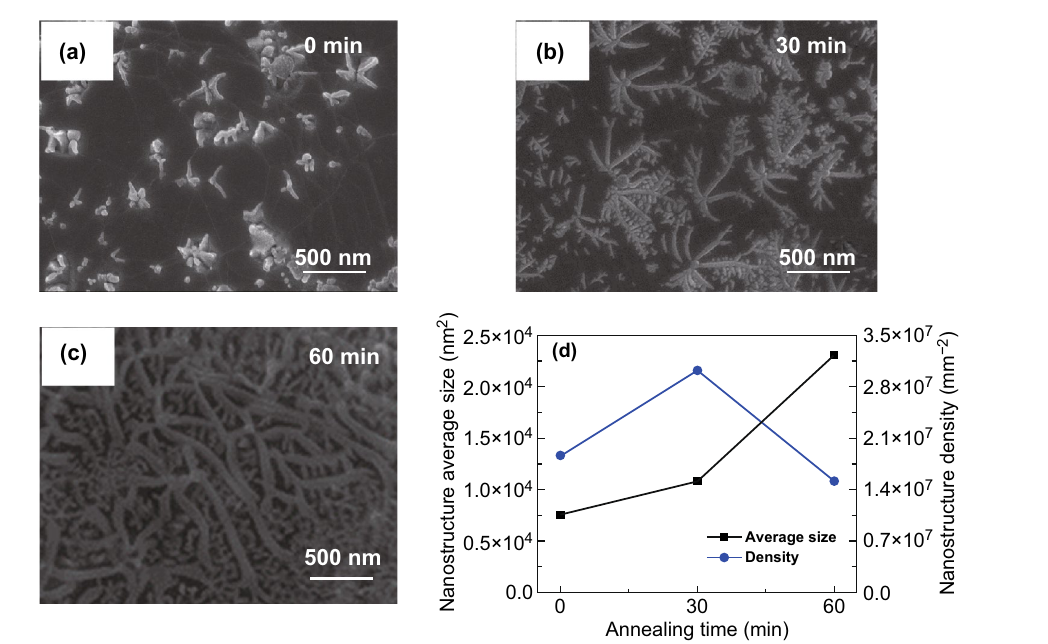
Fig. 3 SEM images of Ni-Si nanostructures for growth periods a of 0 min with 6.25% carbon content, b of 30 min with 6.25% carbon content, c of 60 min with 6.25% carbon content. d Time-dependent variation in the average size and density of nanostructures